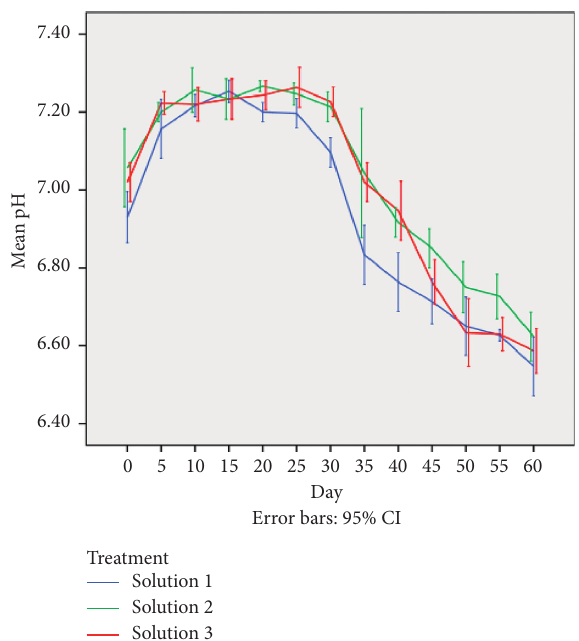
Figure 1: Changes (means ± SD) in the pH of antimicrobial edible coating solutions: solution 1 (0.250 g/L Delvocid), solution 2 (0.275 g/L Delvocid), and solution 3 (0.300 g/L Delvocid) during the storage at 8 ° C and 85% RH.